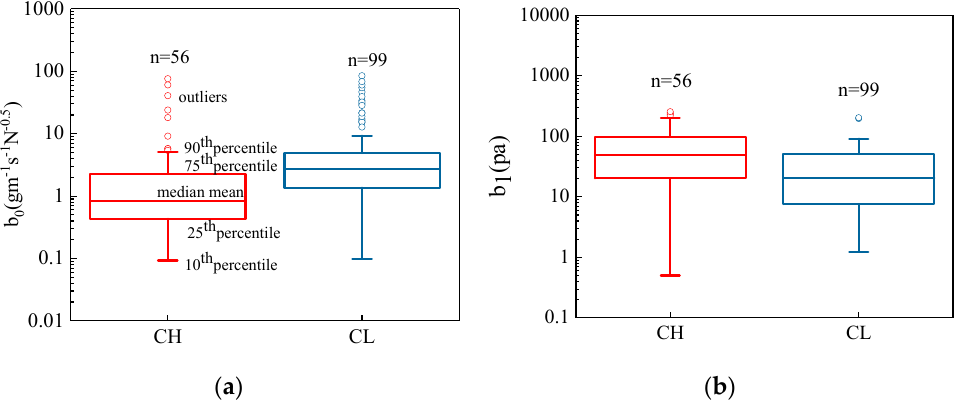
Figure 4. The range of derived parameters b 0 ( a ) and b 1 ( b ) for high-plasticity clay and low-plasticity clay.